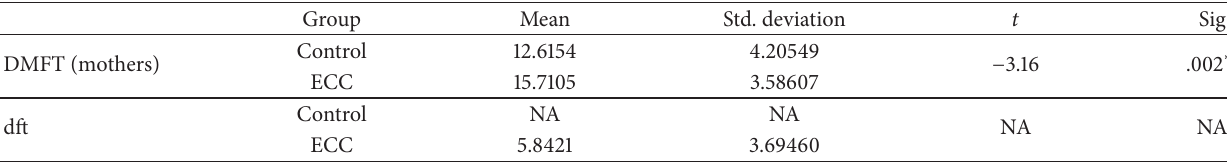
Table 1: Caries distribution of the study population.